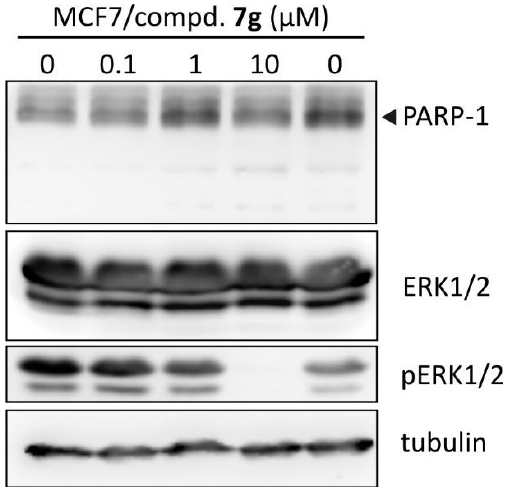
Figure 10. Compound 7g inhibits mitogenic transducer pERK1 / 2 in MCF-7 cells. MCF-7 cells were treated with vehicle or the indicated concentrations of 7g for 1 h.